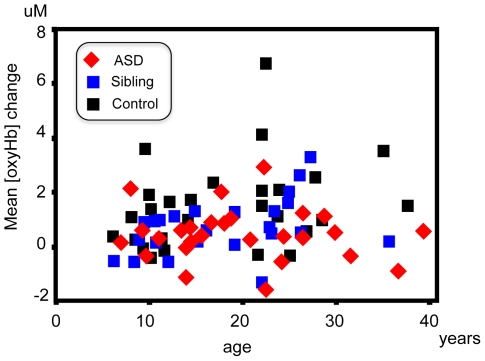
The scatter plot of age and the mean [oxy-Hb] change between hemispheres.Red: autism spectrum disorder, blue: unaffected siblings, black: healthy control.